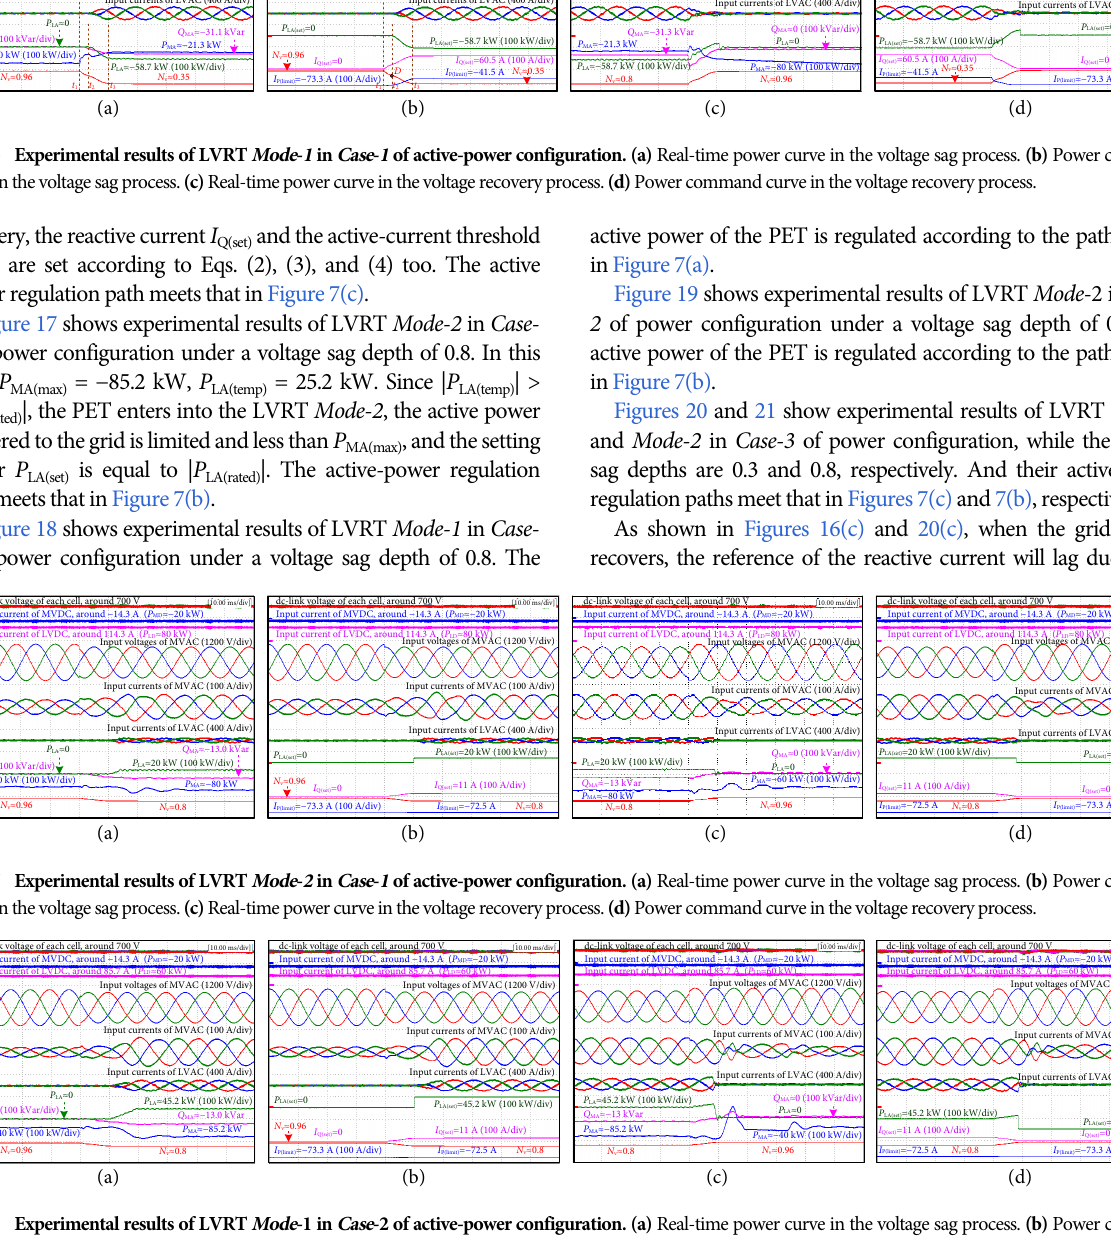
Fig. 18 Experimental results of LVRT Mode-1 in Case-2 of active-power configuration. (a) Real-time power curve in the voltage sag process. (b) Power command curve in the voltage sag process. (c) Real-time power curve in the voltage recovery process. (d) Power command curve in the voltage recovery process. dc-link voltage of each cell, around 700 V dc-link voltage of each cell, around 700 V dc-link voltage of each cell, around 700 V Input current of MVDC, around −14.3 A ( P MD ≈−20 kW) Input current of MVDC, around −14.3 A ( P MD ≈−20 kW) Input current of MVDC, around −14.3 A ( P MD ≈−20 kW) Input current of LVDC, around 71.4 A ( P LD ≈50 kW) Input current of LVDC, around 71.4 A ( P LD ≈50 kW) Input current of LVDC, around 71.4 A ( P LD ≈50 kW)